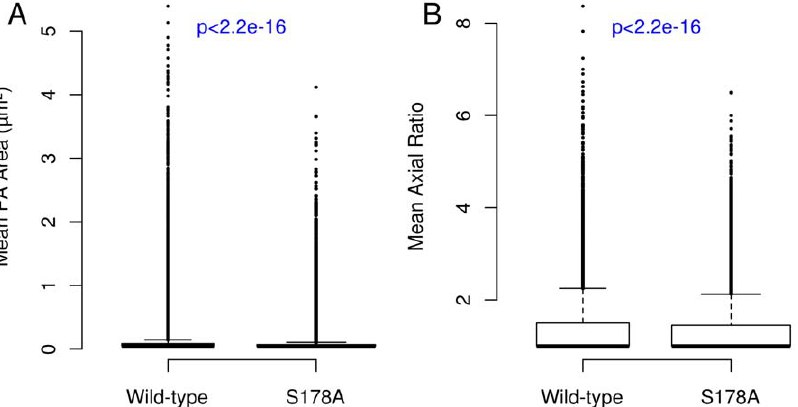
Figure 6. The S178A mutation in Paxillin decreases adhesion size and axial ratio. There are 44685 adhesions in the wild-type and 73305 adhesions in the S178A data sets. The p-values were calculated using the Wilcox Rank Sum test. Data from 9 cells are included in the S178A data set.